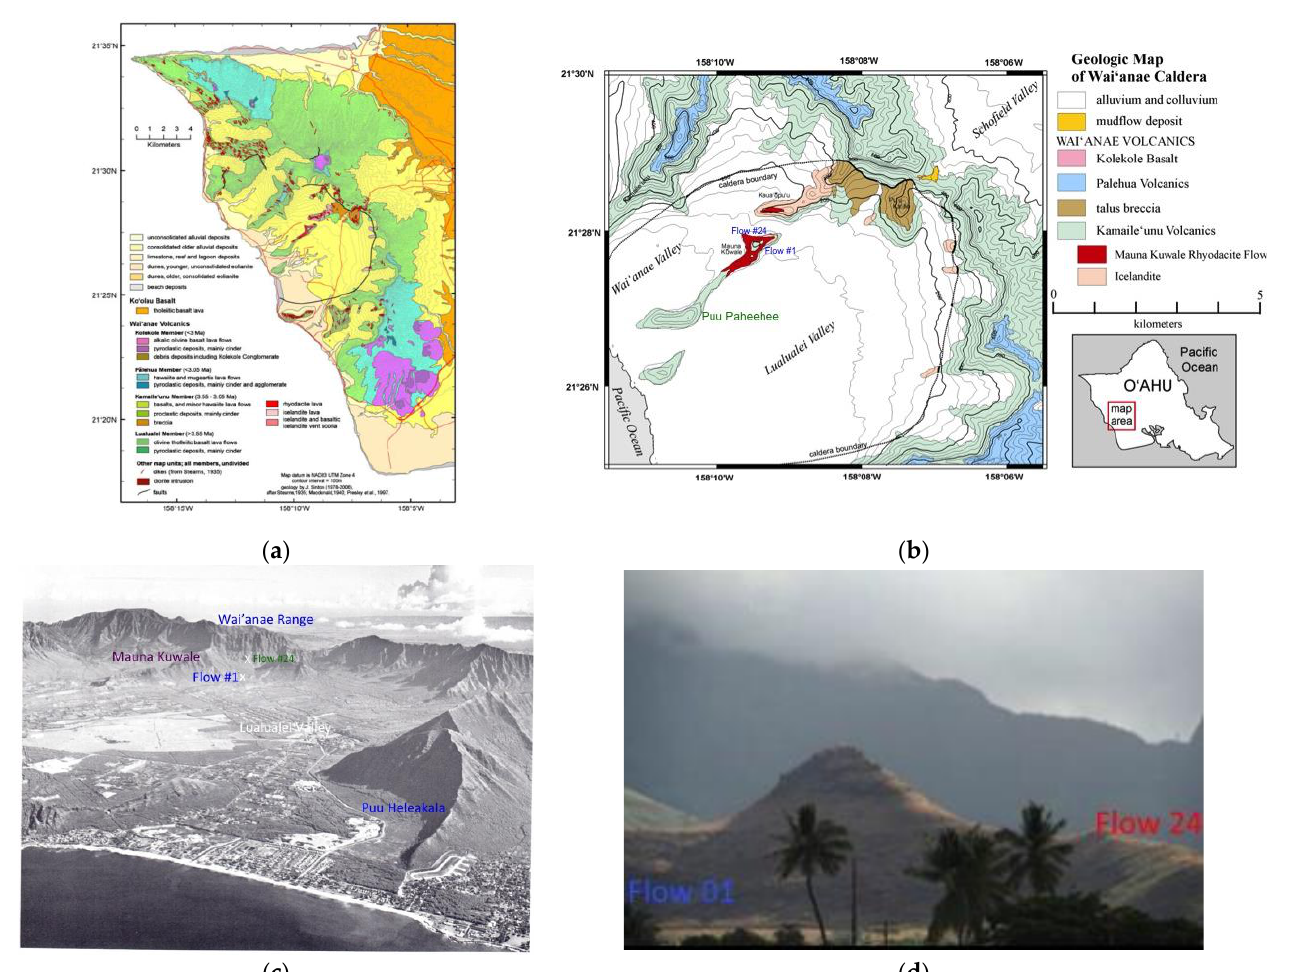
Figure 1. ( a ) Geologic map of the Wai’anae Range, modified after [12,16,18,19]. ( b ) Geologic map of the caldera region. The caldera boundary fault is shown (dotted where covered) modified after [19]. ( c ) Lualualei Valley in the center photo is separated from Nanakuli Valley (out of view) by the prominent peak Puu Heleakala, in the right foreground Kolekole pass (at the center) and Kaala (the flat-topped peak on the left), and in the far background Koolau Range, modified after [1], ( d ) Mauna Kuwale view from the West. The place in the background ridge is Kolekole pass, the location of the first lava flow #1 (in blue) is the base of the long volcanic sequence and in red is the top of the place were the last flow was sampled for the present study. Modified after